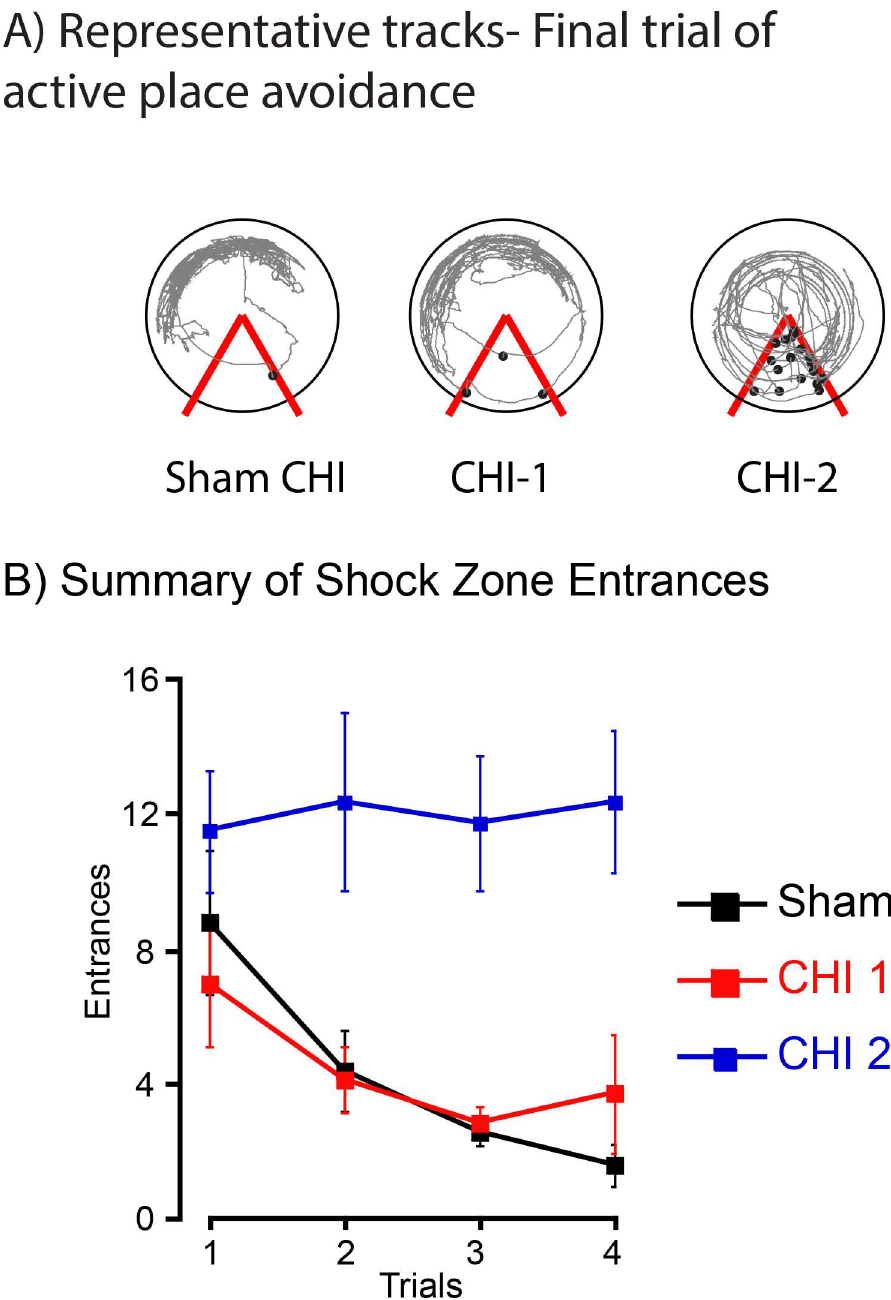
Fig 2. CHI-1, but not CHI-2 mice acquired an active place avoidance task. The sham-CHI, CHI- 1 or CHI-2 groups received four 10-minute trials with a 50-minute intertrial interval. Panel A, Representative tracks of the final trial of sham-CHI, CHI-1 and CHI-2 mice. The 60˚ stationary shock zone is shown in red. Black circles show the location of the mouse when being shocked. Panel B, Summary of total shock zone entrancesduring the 4 trials of active place avoidance. The number of shock zone entrancessignificantly differed on the basis of trial number for the Sham-CHI (F 3,12 = 12.88, p < 0.0005) and the CHI-1 groups (F 3,18 = 8.07, p = 0.001), but not for the CHI 2 group (F 3,21 = 0.32, p = 0.81). Furthermore, there was a statistically significant interaction between group and trial number (F 6,51 = 3.81, p < 0.003). The CHI-2 group had significantly more shock zone entrancesthan the sham-CHI or CHI-1 groups. In contrast, the sham-CHI and CHI-1 groups had a similar number of shock zone entrances(post hoc, p = 0.05) suggesting that the sham- CHI and CHI-1 groups, but not the CHI-2 group acquiredthe shock zone